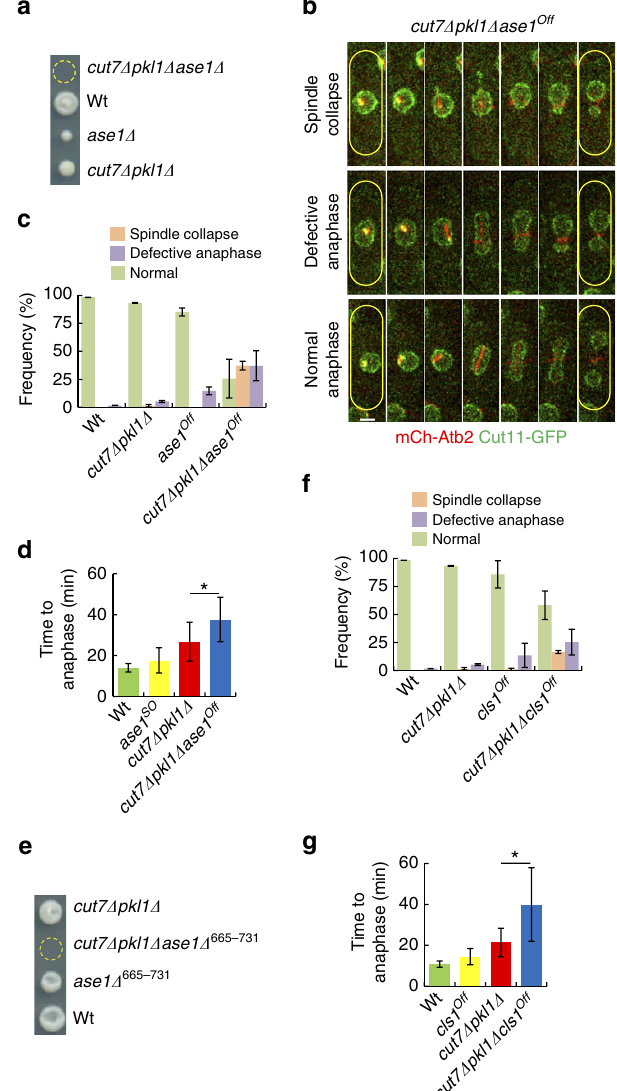
Figure 3 | Ase1 and Cls1 are critical for spindle assembly in cut7 D pkl1 D cells. ( a ) Tetrad dissection of cut7 D pkl1 D cells crossed to ase1 D cells. ( b ) Time-lapse images of cut7 D pkl1 D ase1 Off mitotic cells expressing mCherry-Atb2 and Cut11-GFP (NE marker), after 20h of repression/ shut-off. Each frame corresponds to 5min interval. Each row of images represents the detected phenotypes. ( c ) Bar plot of frequencies of spindle phenotypes in wild-type ( n ¼ 240), cut7 D pkl1 D ( n ¼ 197), ase1 Off ( n ¼ 123) and cut7 D pkl1 D ase1 Off cells ( n ¼ 88) after 20h of repression/shut-off. ( d ) Bar plot showing the anaphase transition time of wild-type (green; n ¼ 17), ase1 Off (yellow; n ¼ 23), cut7 D pkl1 D (red; n ¼ 25), cut7 D pkl1 D ase1 Off cells (blue; n ¼ 21) after 20h of repression/shut-off. * P o 0.001. ( e ) Tetrad dissection of cut7 D pkl1 D cells crossed to ase1 D 665-731 cells. ( f ) Bar plot of frequencies of spindle phenotypes in wild-type ( n ¼ 240), cut7 D pkl1 D ( n ¼ 197), cls1 Off ( n ¼ 109) and cut7 D pkl1 D cls1 Off cells ( n ¼ 121) after 20h of repression/shut-off. ( g ) Bar plot showing anaphase transition time of wild-type (green; n ¼ 42), cls1 Off (yellow; n ¼ 33), cut7 D pkl1 D (red; n ¼ 29) and cut7 D pkl1 D cls1 Off cells (blue; n ¼ 28) after 20h of repression/shut-off. * P o 0.001. Data show mean ± s.d. and Student’s t -test P value. Scale bars, 2 m